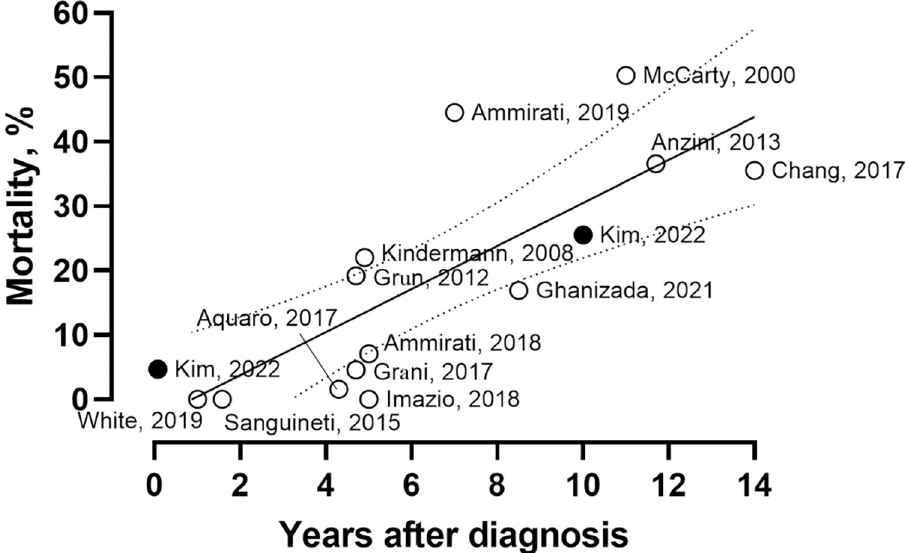
Fig 3. Comparison of the all-cause mortality results with the previous studies [7, 8, 10, 11, 13–15, 17, 19–22].